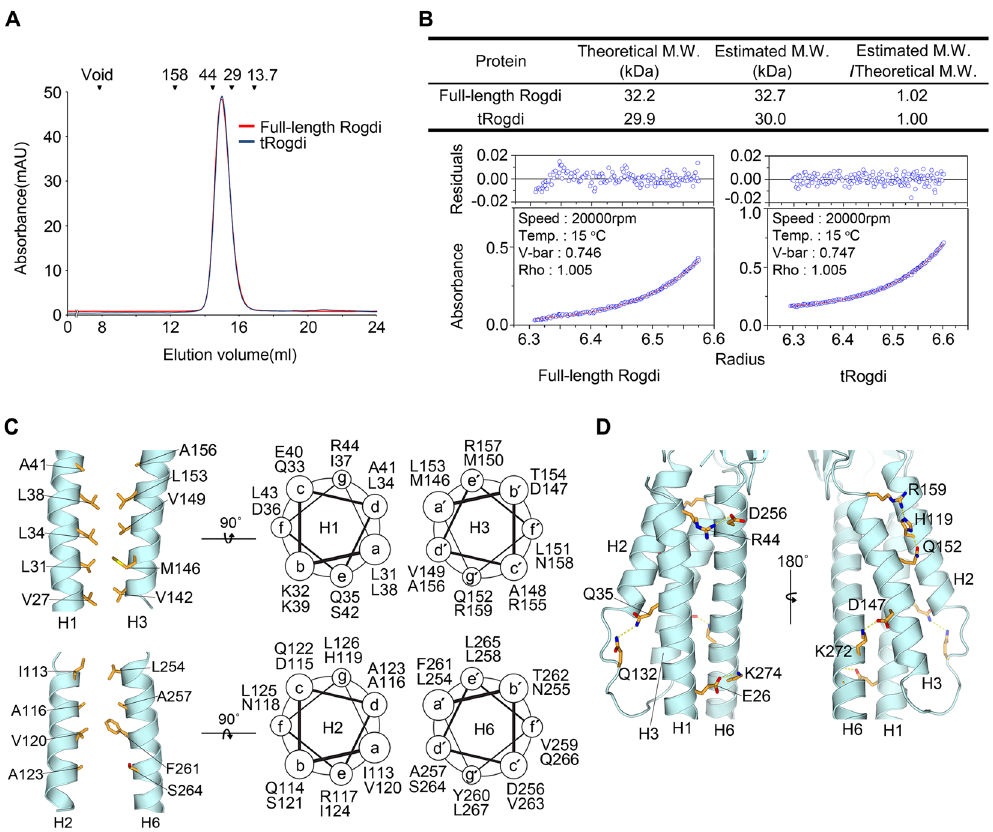
Figure 3. The Leucine Zipper-Like Domain of Rogdi. ( A ) Size-exclusion chromatography analysis of full- length and truncated (residues 11–276) Rogdi showing the oligomeric state. Molecular mass standards for SEC experiments (top) were aldolase (158 kDa), ovalbumin (44 kDa), carbonic anhydrase (29 kDa) and RNase A (13.7 kDa). Chromatography was performed on a Superdex 200 column in buffer containing 25 mM TRIS, 150 mM NaCl, and 5 mM DTT (pH 7.5). ( B ) Equilibrium fitting of the results of analytical ultracentrifugation for full-length (left) and truncated (right) Rogdi. The lower panel depicts the fitted overlay (red line) to the experimental data (blue circles). The upper panel depicts the residuals. ( C ) Helical wheel representation and cartoon diagrams showing the heptad repeat and intermolecular interactions within two parallel helices (H1/ H3, top and H2/H6, bottom) of the Rogdi α domain. ( D ) Detailed view of the intermolecular hydrogen bonds between the surface of amphipathic helices of the α domain. Dotted lines indicate hydrogen bonds (Q35-Q132, R159-H119, and H119-Q152) and three ion pairs (see text for